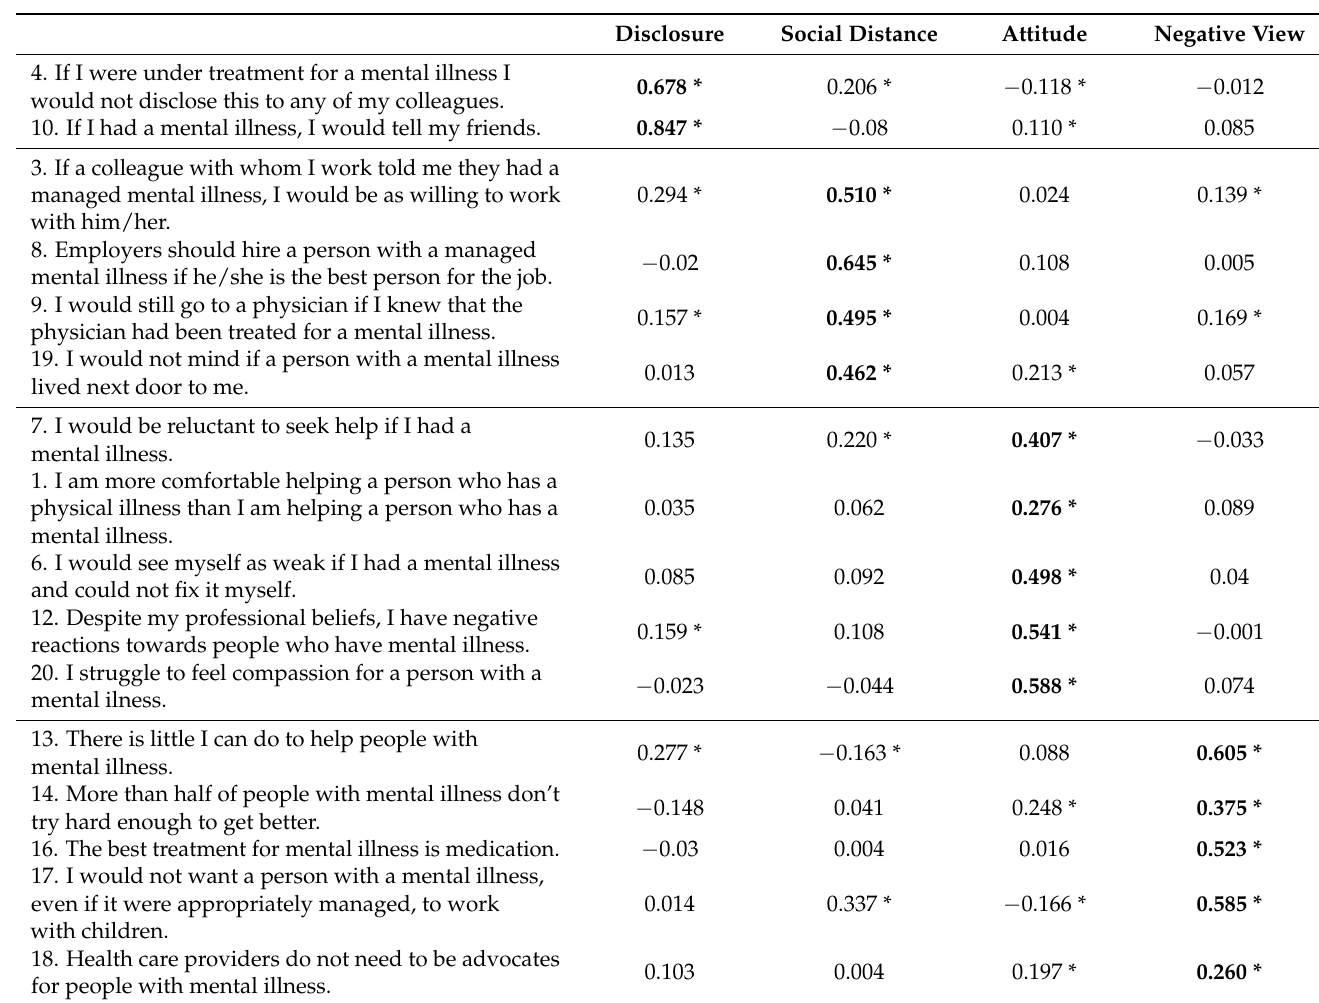
Table 2. Standardized factor loadings for Exploratory Factor Analysis with 4 factors estimated using WLSMV method and GEOMIN rotation. “*” indicates statistical significance. We focus the interpretation of the factors on the loadings that are higher than 0.3 or the loading that is the highest for the item. Disclosure Social Distance Attitude Negative